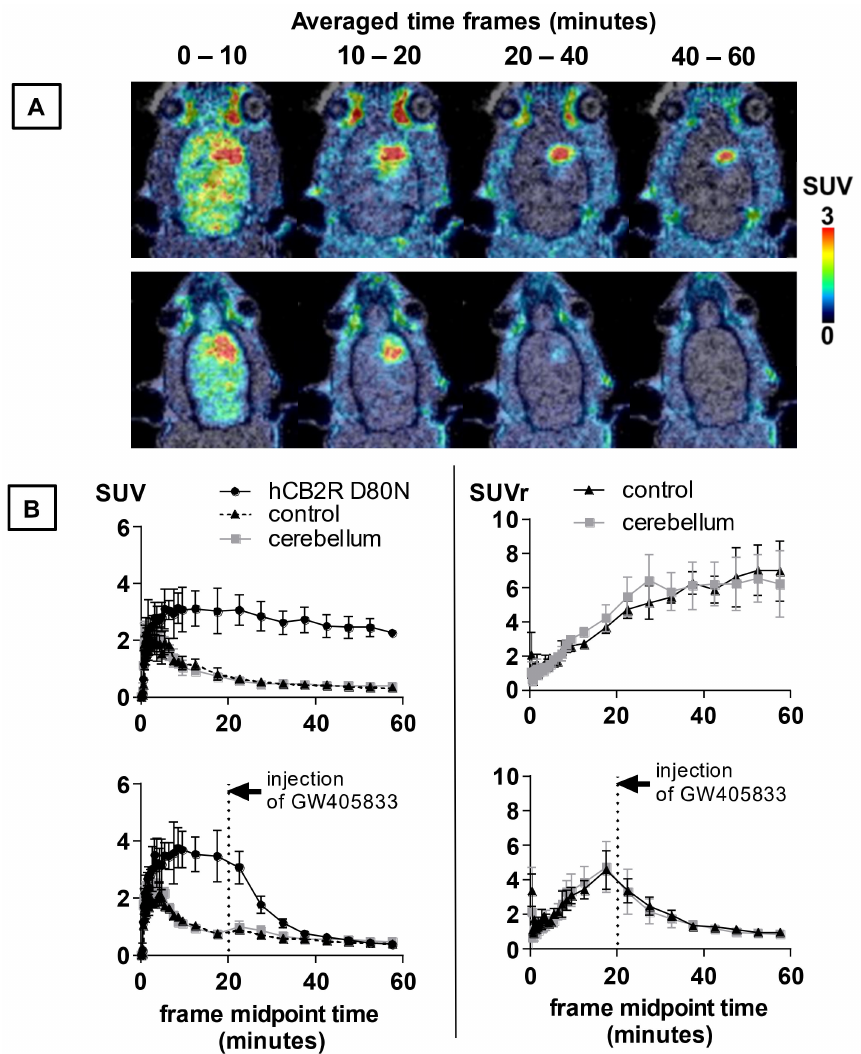
Figure 6. PET imaging of [ 18 F] LU14 in a rat model of local hCB2R overexpression. ( A ) Representative coronal planes showing merged MR and PET images of averaged time frames of the control group (upper row) and displacement study (lower row), ( B ) TACs of the right (hCB2R D80N) and left striatum (contralateral), as well as of the cerebellum on the left side and the SUV hCB2R D80N normalised to contralateral or cerebellum (SUVr), with results of the vehicle treated group in the upper row ( n = 3) and of the displacement studies where GW405833 (5 mg/kg, n = 2) was applied at 20 min. p.i. in the lower